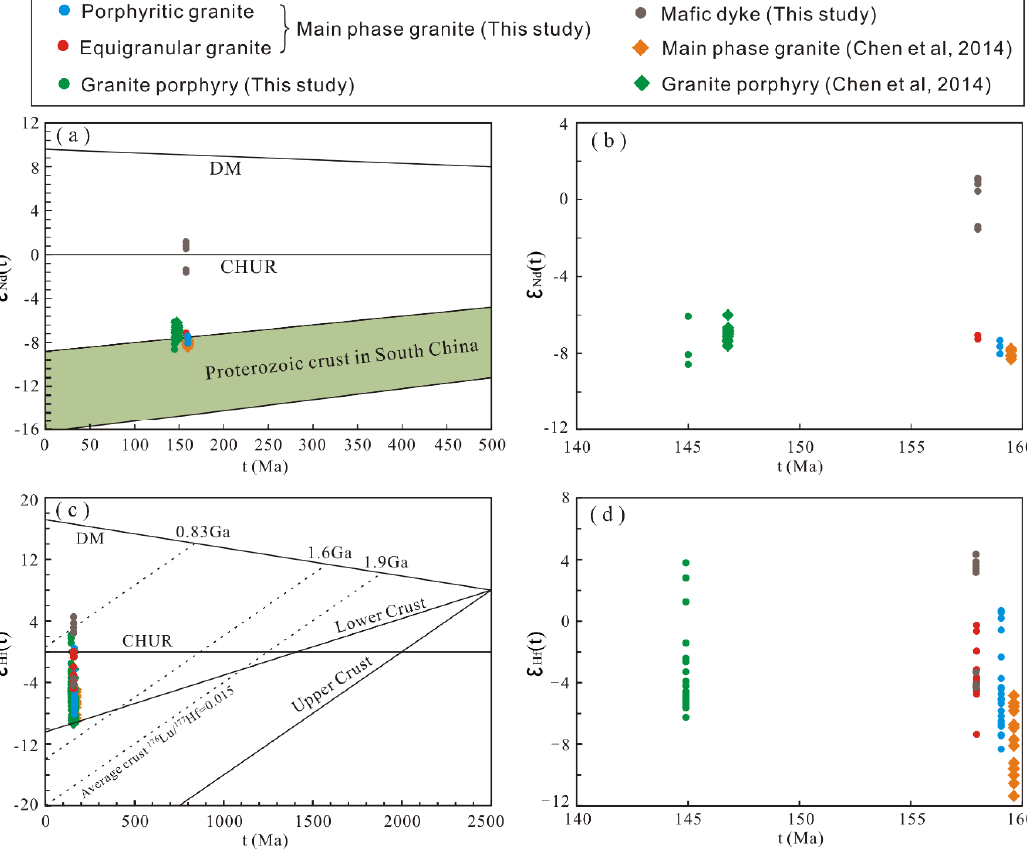
Figure 6. Plots of ε Nd(t) versus t ( a , b ) and ε Hf(t) versus t diagrams ( c , d ) for the granites and mafic dykes of the Qianlishan complex: the ε Nd isotopic evolution fields for Proterozoic crust in South China are cited from Shen et al. [53]. Data cited from Chen et al. [20].